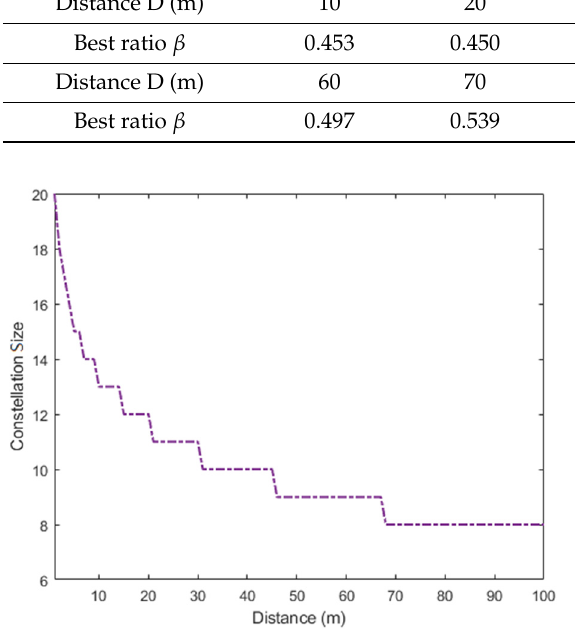
Figure 3. Optimal constellations at different distances.